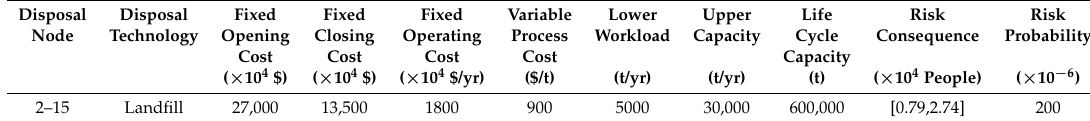
Table 3. Candidate disposal centers.